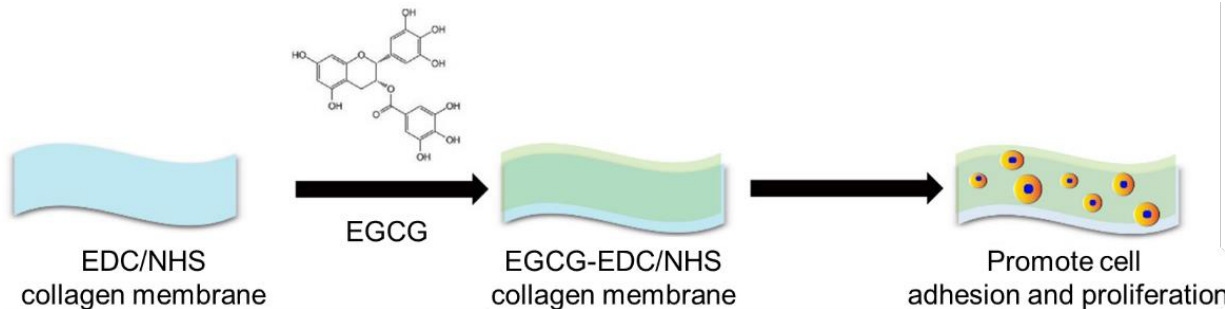
Figure 1. Schematic graph of loading 0.064% EGCG to EDC/NHS collagen membrane.